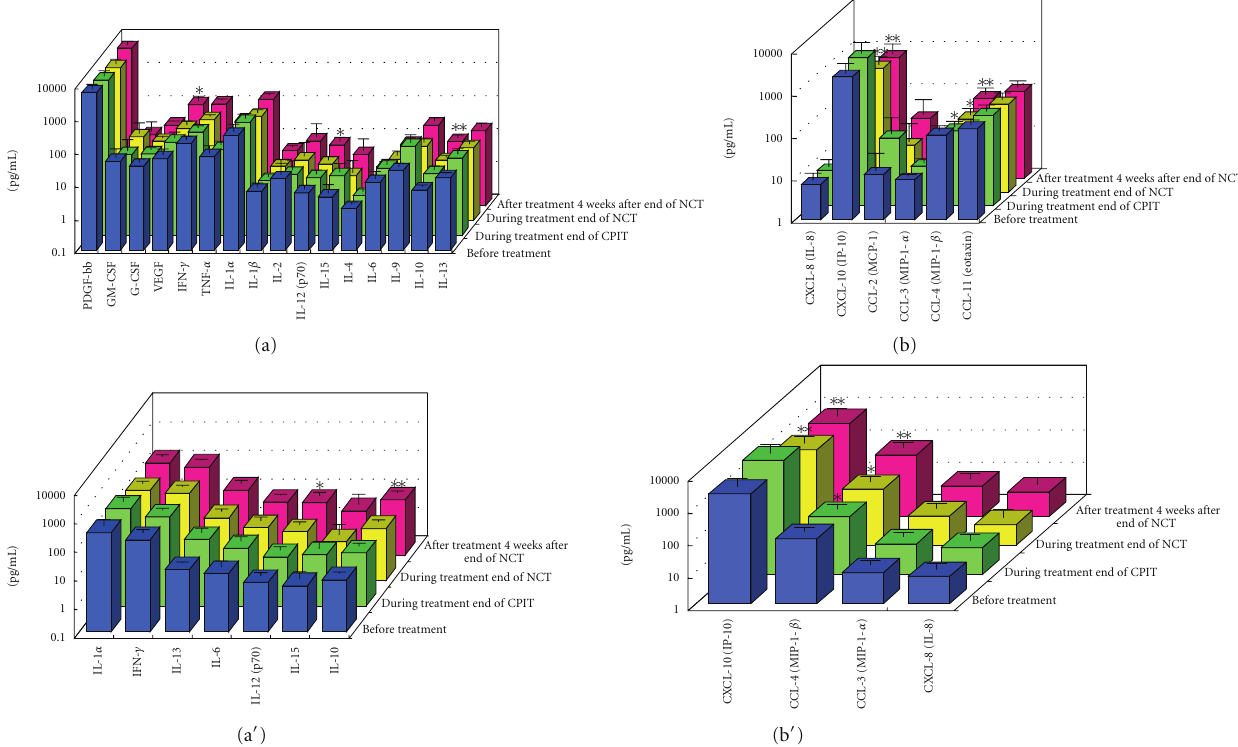
Figure 2: E ff ect of RBV plus PEG-IFN-alpha 2b using an “induction” approach with CPIT (NCT) on serum cytokines (a), (a (cid:3) ) and chemokines (b), (b (cid:3) ) in chronic hepatitis C patients with high viral load, genotype 1b (serotype I), and wild or intermediate type of ISDR (all patients). RBV: ribavirin, PEG-IFN: pegylated interferon, CPIT: cyclic and periodic interferon treatment, NCT: novel combination treatment. Significant di ff erence: ∗ P < 0 . 05, ∗∗ P < 0 .